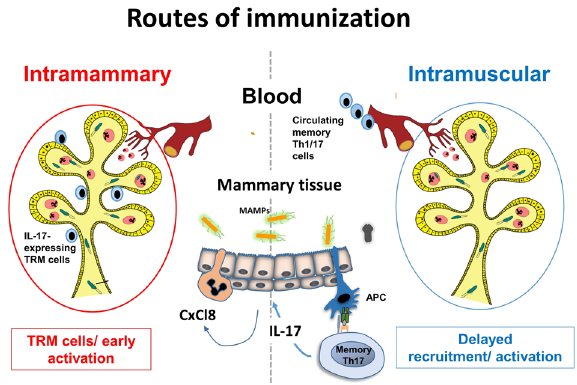
Fig. 7 Local mammary immunization establishes resident mem- ory CD4 T cells in the mammary tissue on the contrary to the intramuscular route of immunization. The schematic describes our current view of the bene fi cial effect of intramammary immunization and compares the two routes of immunization. Systemic injection of killed bacteria in adjuvant produces a pool of Th1/Th17 circulating CD4 T cells. Injection of E. coli culture supernate antigens via the teat ductal route enables settlement of CD4 TRM cells in the mammary tissue that are poised to express IL-17 and mobilize a protective response through neutrophil recruitment early during the course of an E. coli